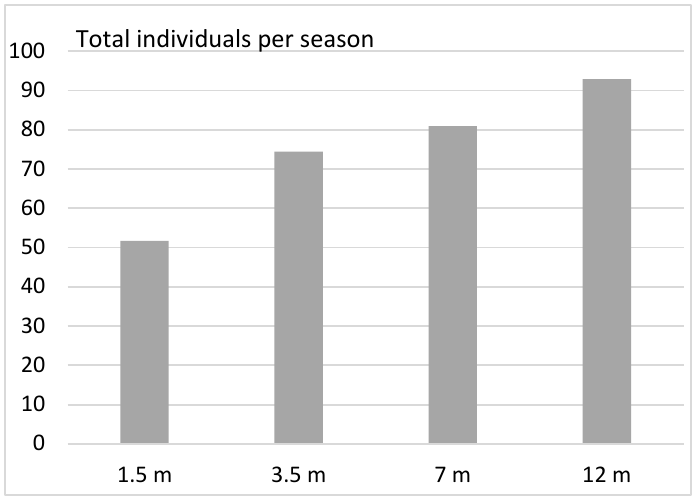
Figure 2. Lepidoptera total abundance at various heights in deciduous forests.